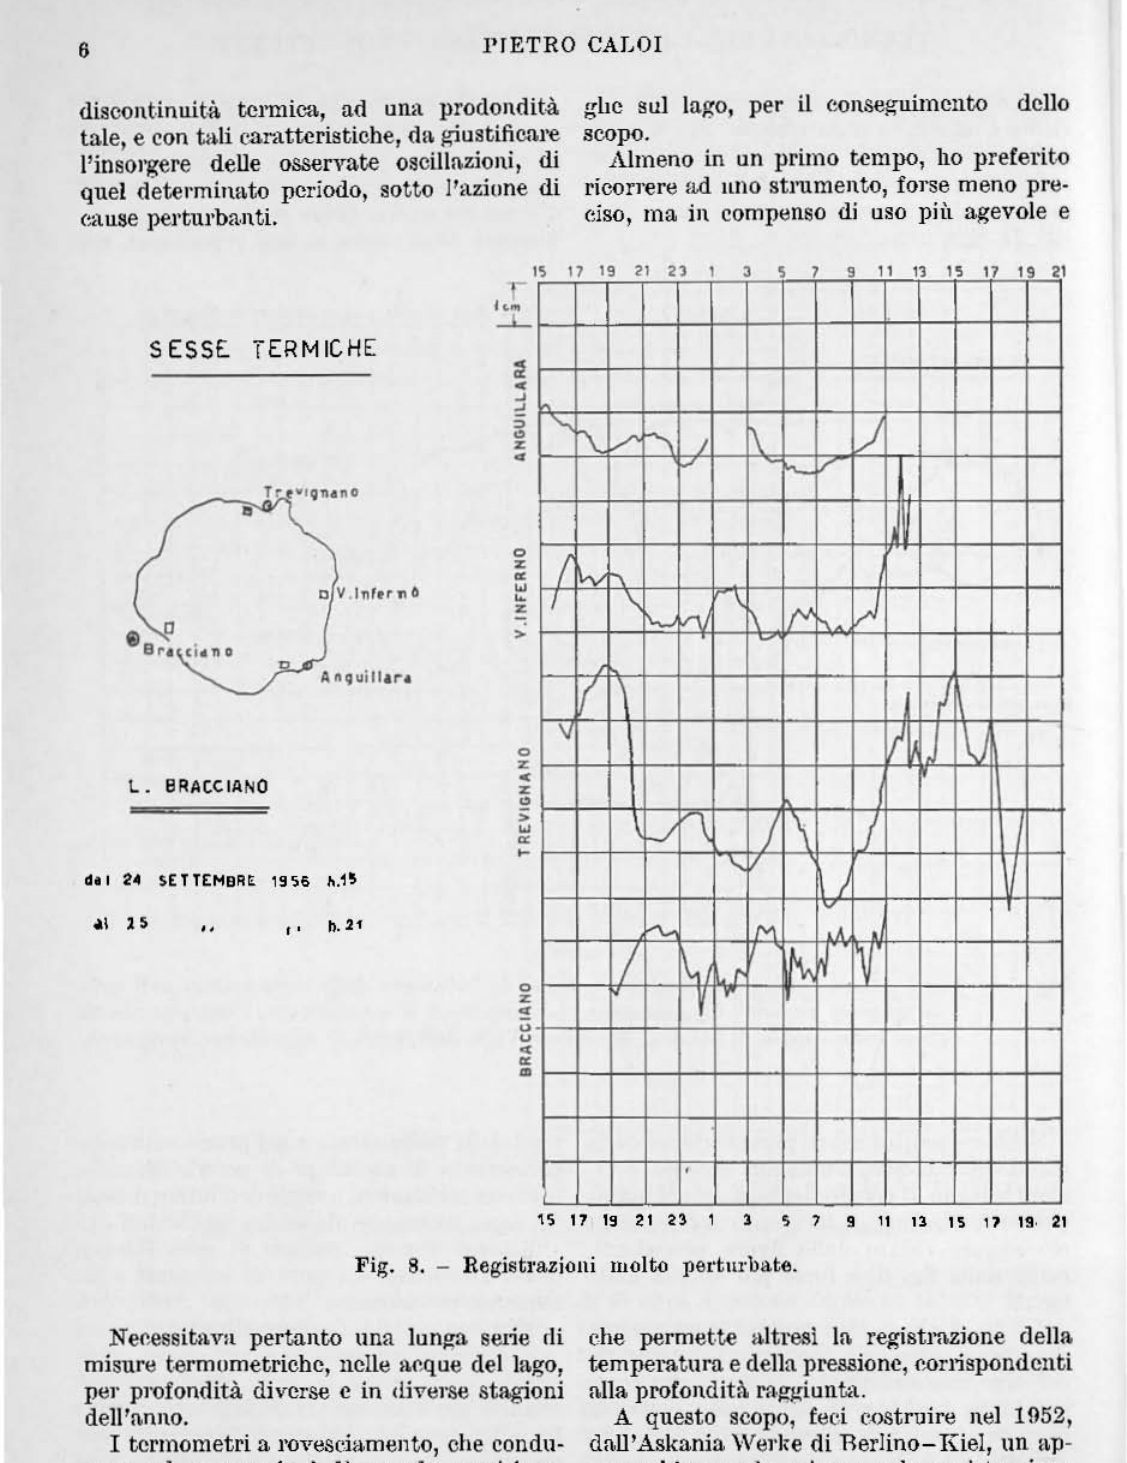
Fig. 8. - Regi~tr&Ziolli molto